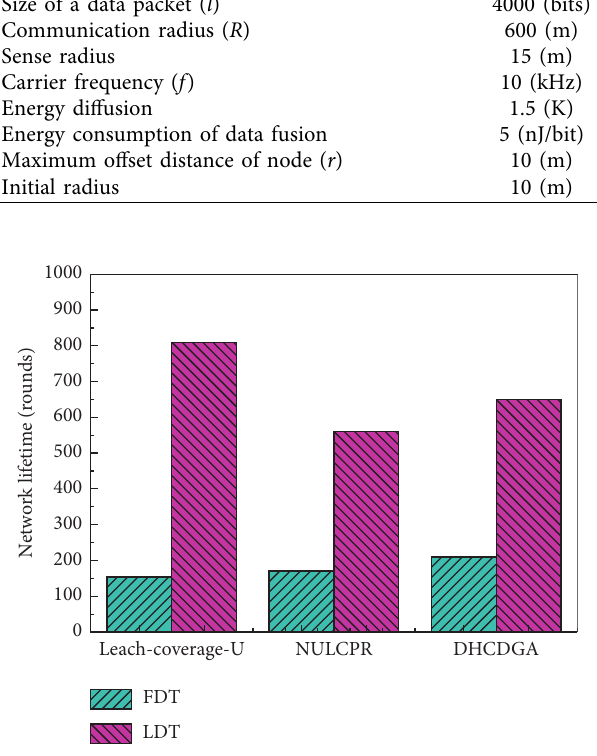
Figure 4: Network lifetime.